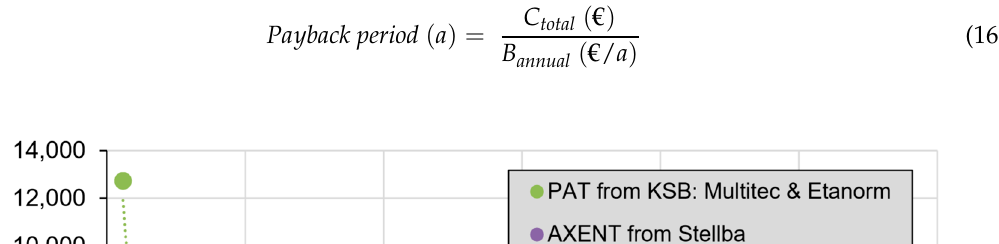
Table 2. Summary of cost parameters for AXENT turbines and PATs.